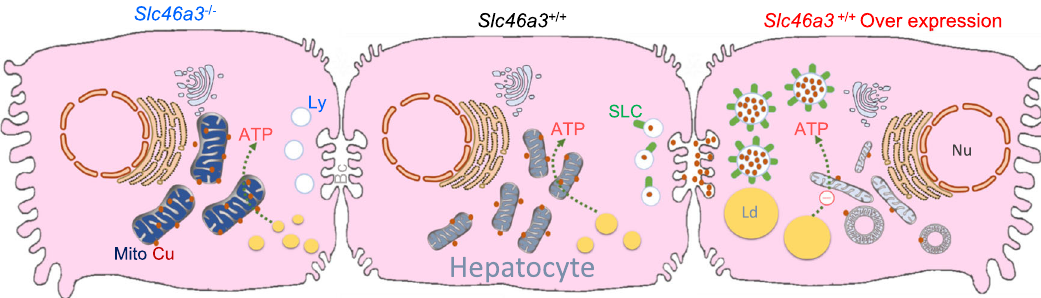
Fig. 8 Scheme showing a possible role of SLC46A3 in hepatic lipid accumulation in mice. In the normal state of hepatocytes, intracellular copper levels can be balanced by homeostasis, but induction of SLC46A3 by TCDD can lead to an abnormal increase in copper migration to lysosomes. Conversely, a mild increase of copper in the cytosol may inhibit TG accumulation in liver. Thus, the lack of intracellular copper levels can result in mitochondrial dysfunction. Ultimately, lipids such as TG are stored in the form of lipid droplets. Nu Nucleus; Mito Mitochondria; Ly Lysosome; SLC SLC46A3; Cu Copper; Ld Lipid droplet; Bc Bile